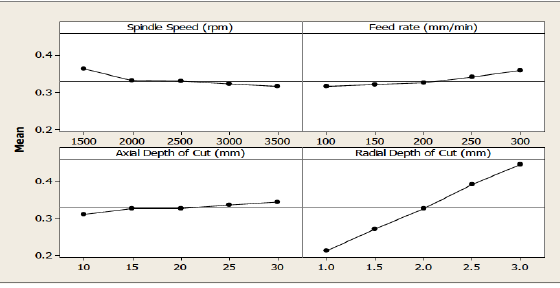
Figure 9: Effects of the Four Parameters on the Tool